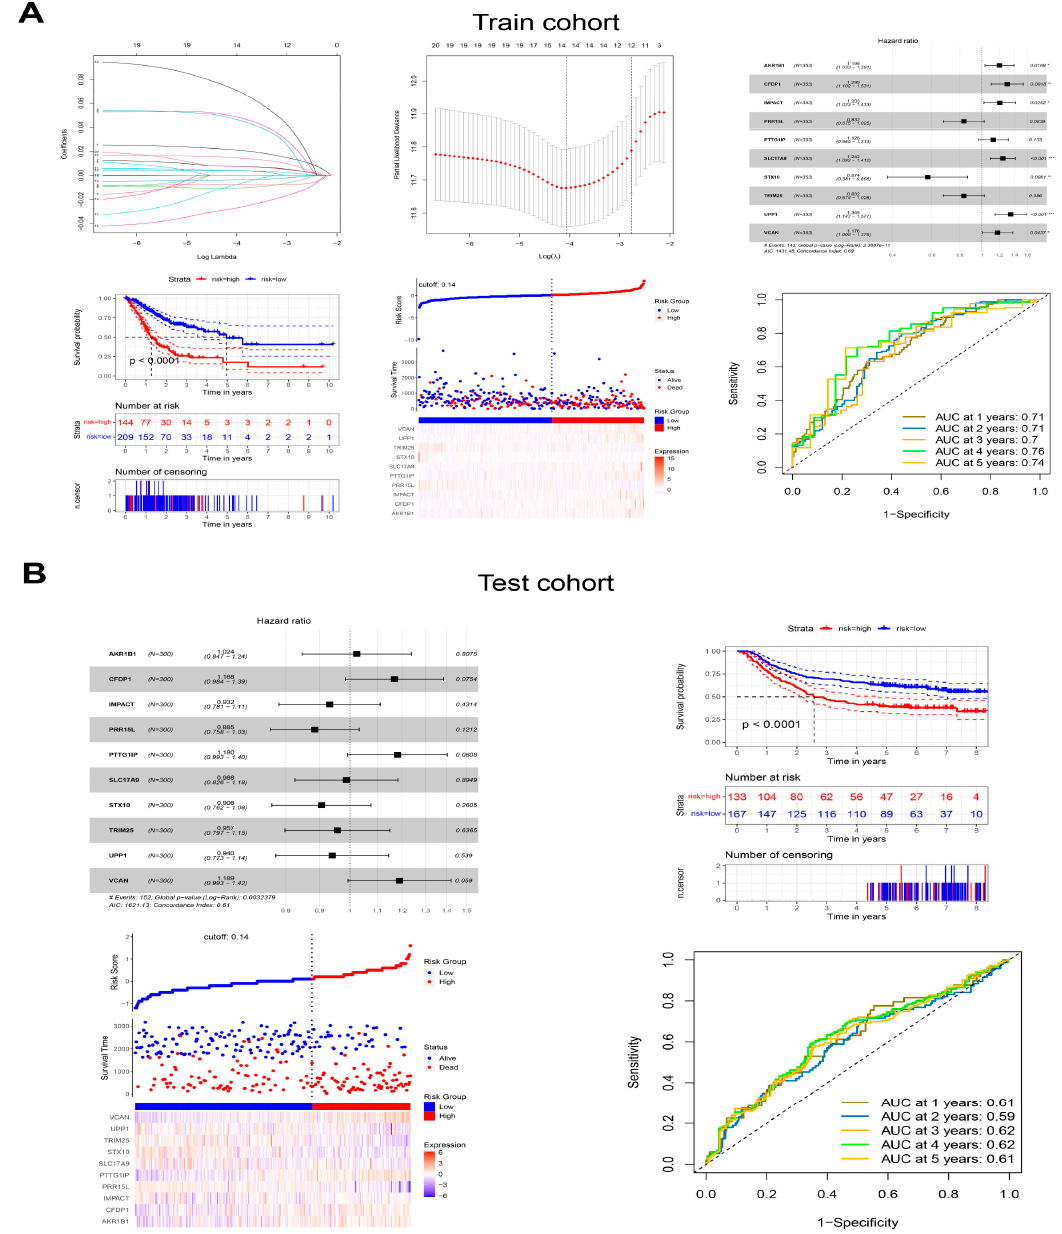
Figure 12. Generation and validation of the prognostic signatures in malignant epithelial cells. ( A ) The generation of the prognostic signatures in the training cohort. ( B ) The validation of the prognostic signatures in the test cohort. * p < 0.05, ** p < 0.01, *** p <